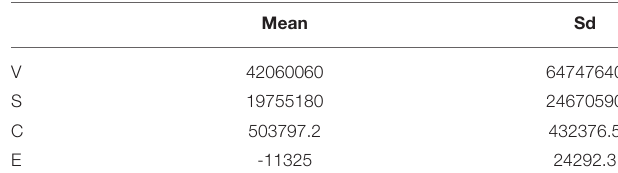
TABLE 2 | Means and standard deviation of variables V , S , C , and E .